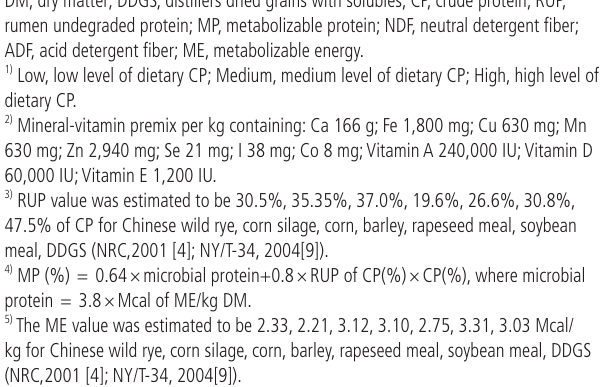
Dietary treatment